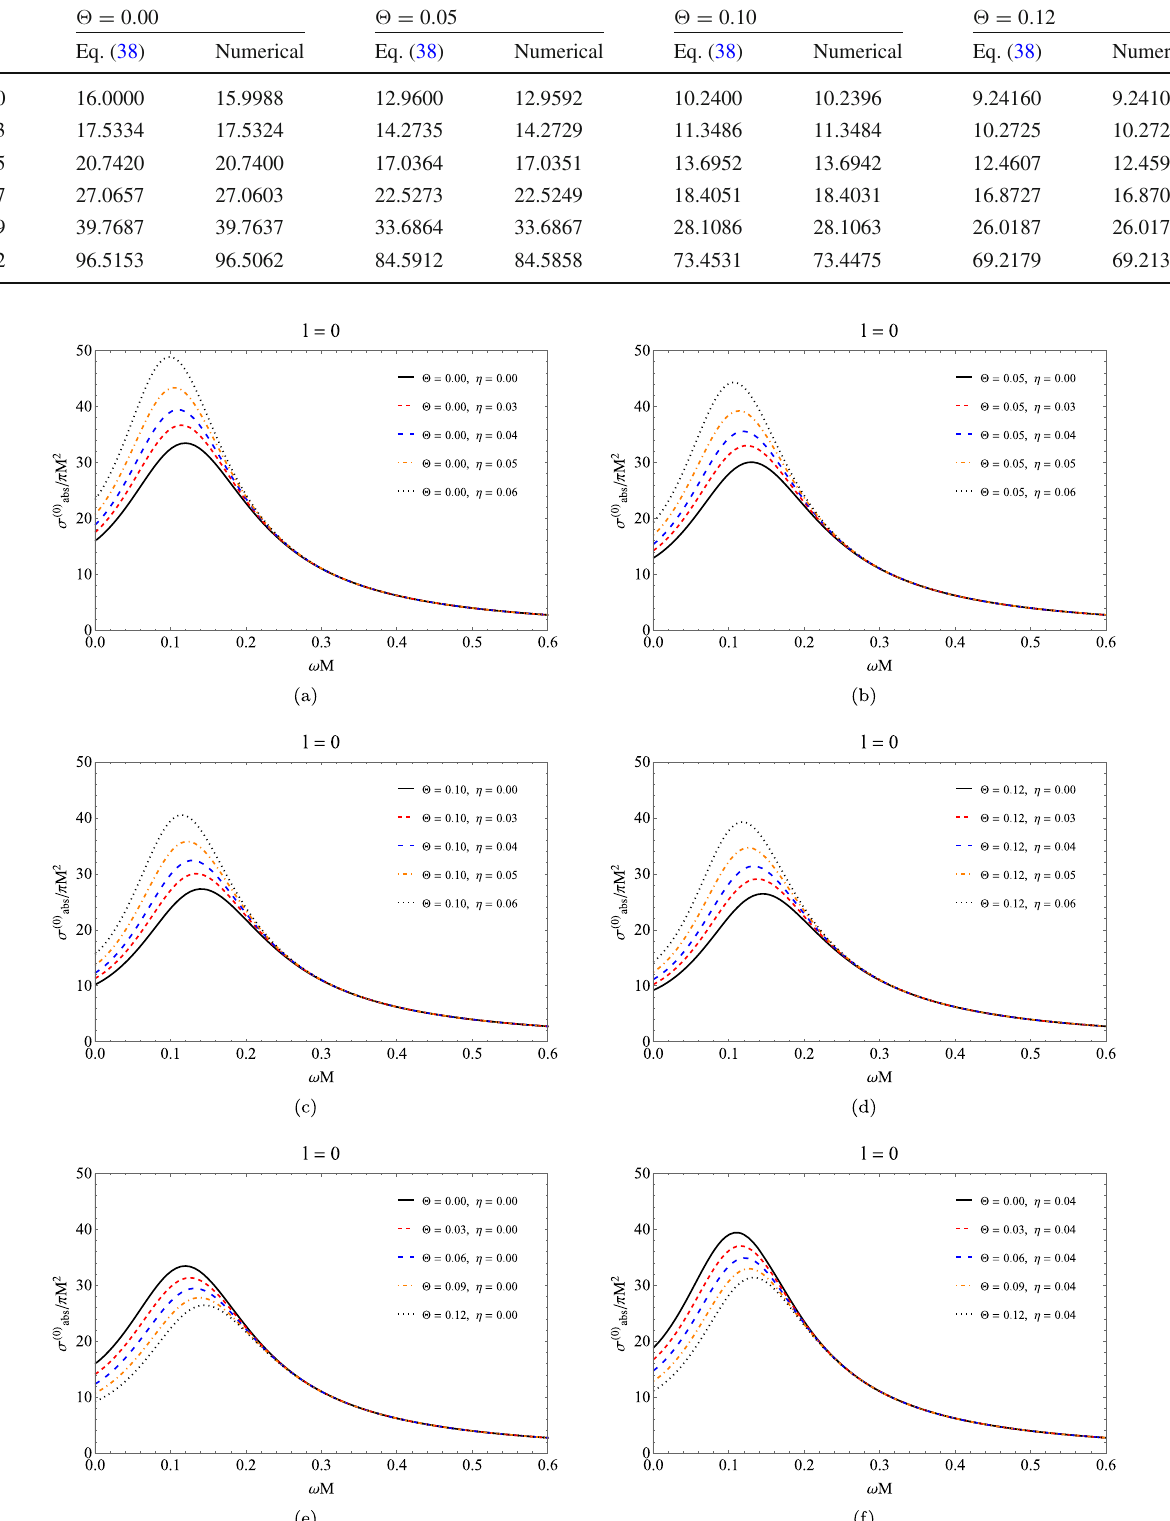
Fig. 3 Absorption cross section for l =